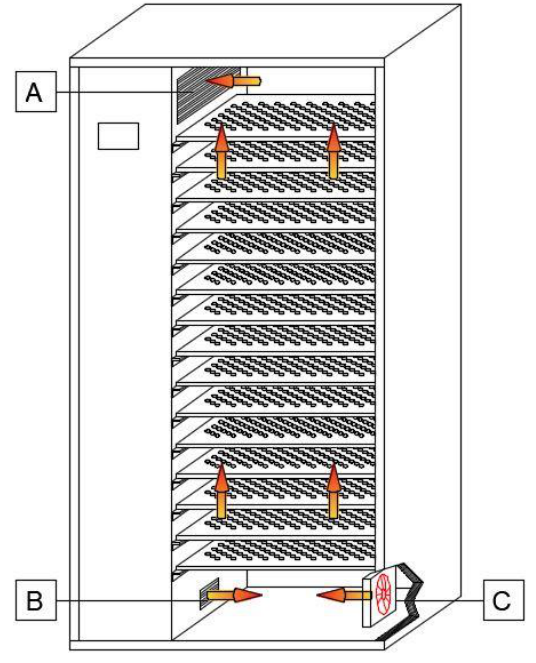
Figure 2. Diagram of air flow through a drying chamber, with modification 4. A—air inlet; B—air outlet; C—additional fan. The arrows indicate the direction of the air flow.